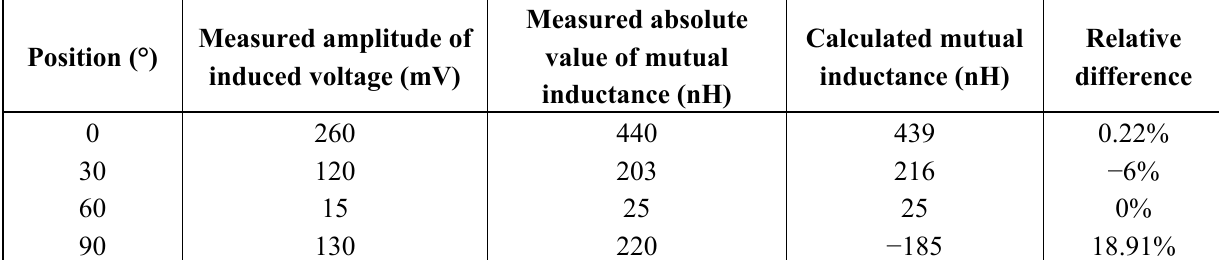
Table 2. Measurement results with the open rotor–induced voltage and absolute value of mutual